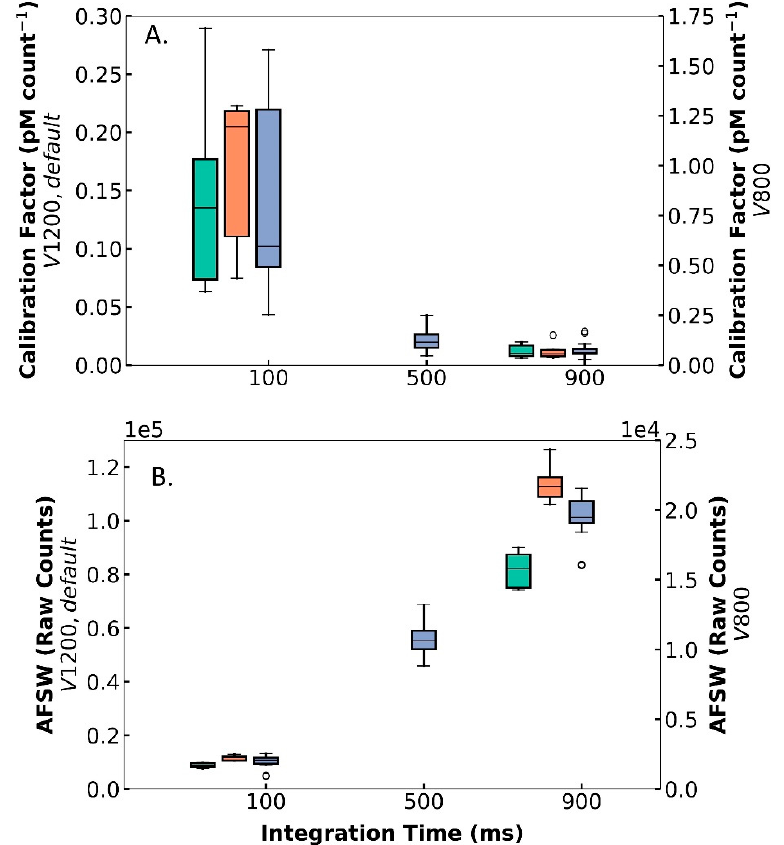
Figure 4. Results from multiple laboratory tests with DISCO, showing the ( A ) calibration factor (y-axis, pM count − 1 ) and ( B ) AFSW raw counts (y-axis) across integration time (x-axis, ms) for different voltages (V): 800 (right y-axis, green), 1200 (left y-axis, orange), and default (left y-axis, blue). The box and whisker plot indicates the middle 50 percentile (box), the median (horizontal line), the middle 90 percentile (vertical lines), and the outliers (“o”).